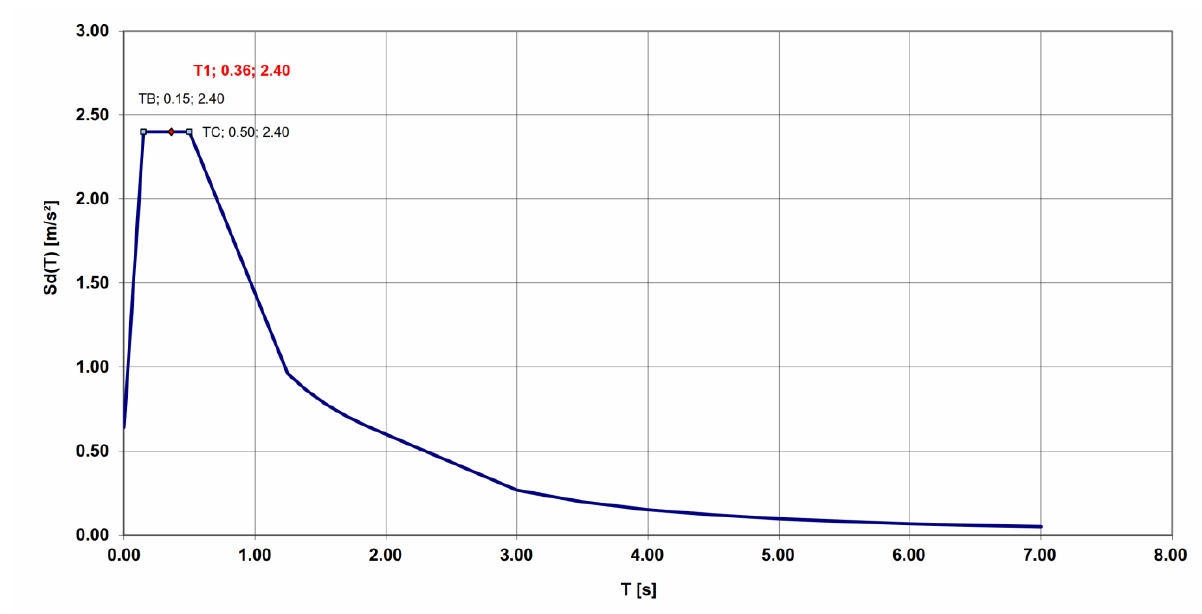
Figure 4. Horizontal elastic response spectrum.